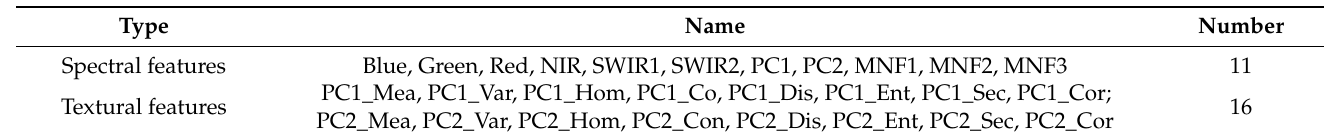
Table 2. Features used in the